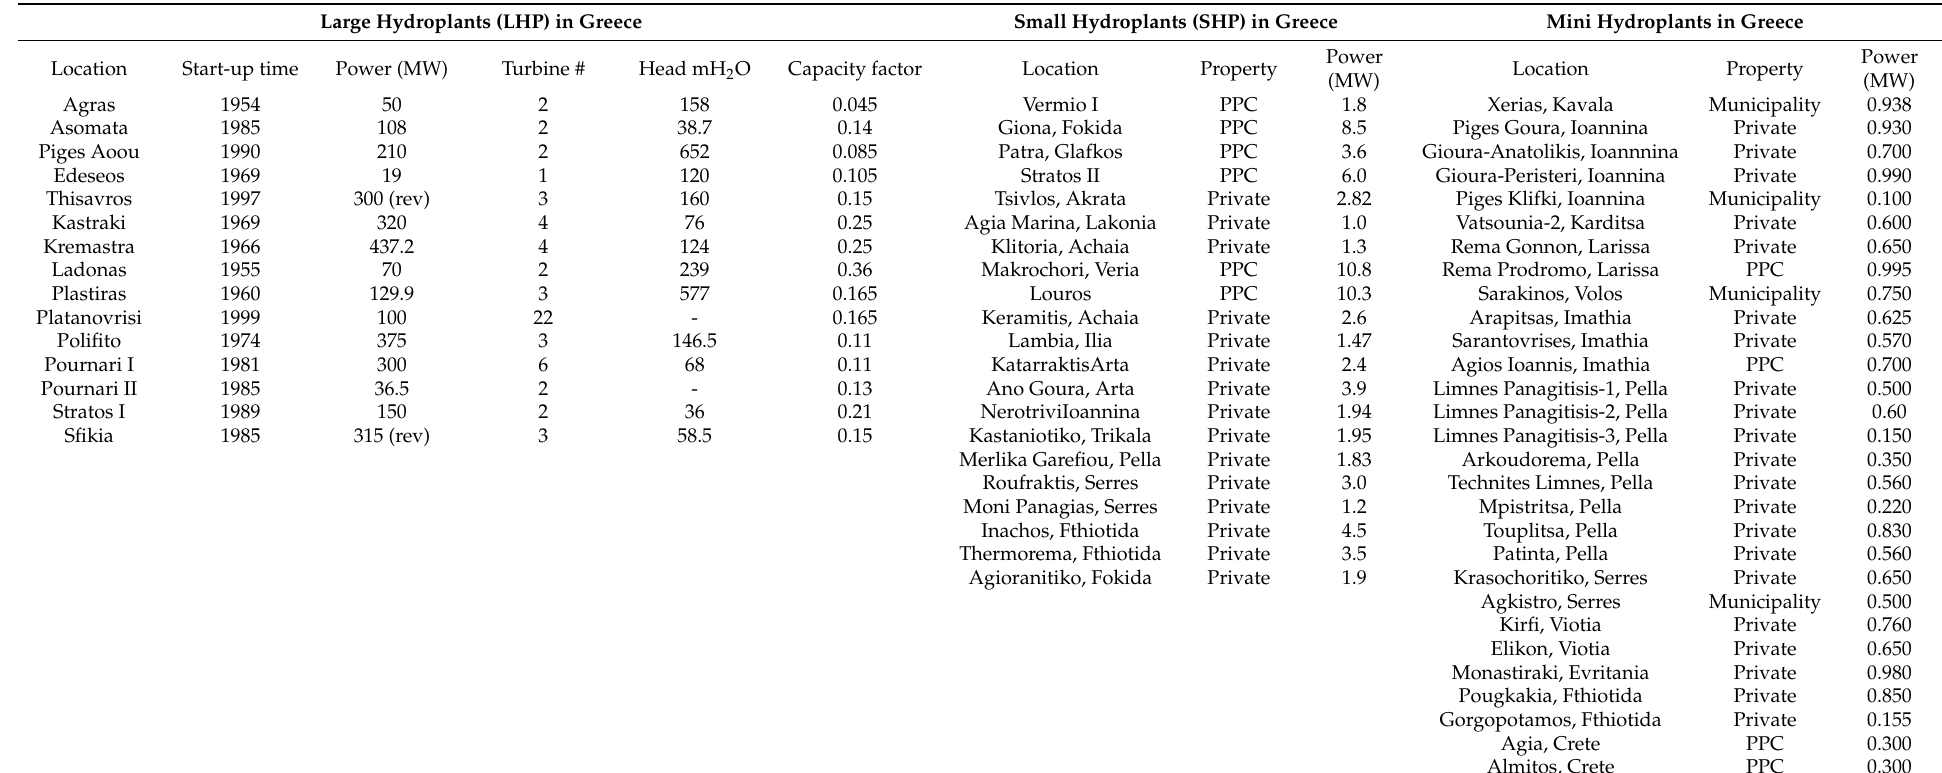
Table 3. Main characteristics of existing large, small, and mini hydropower plants in